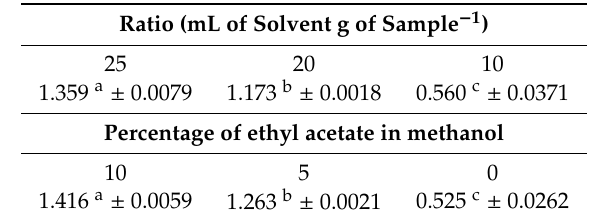
Table 4. Values of ricinine (mg. g of sample −1 ) for MAE at different ratios and solvent compositions (mean ± RSD) 1 .